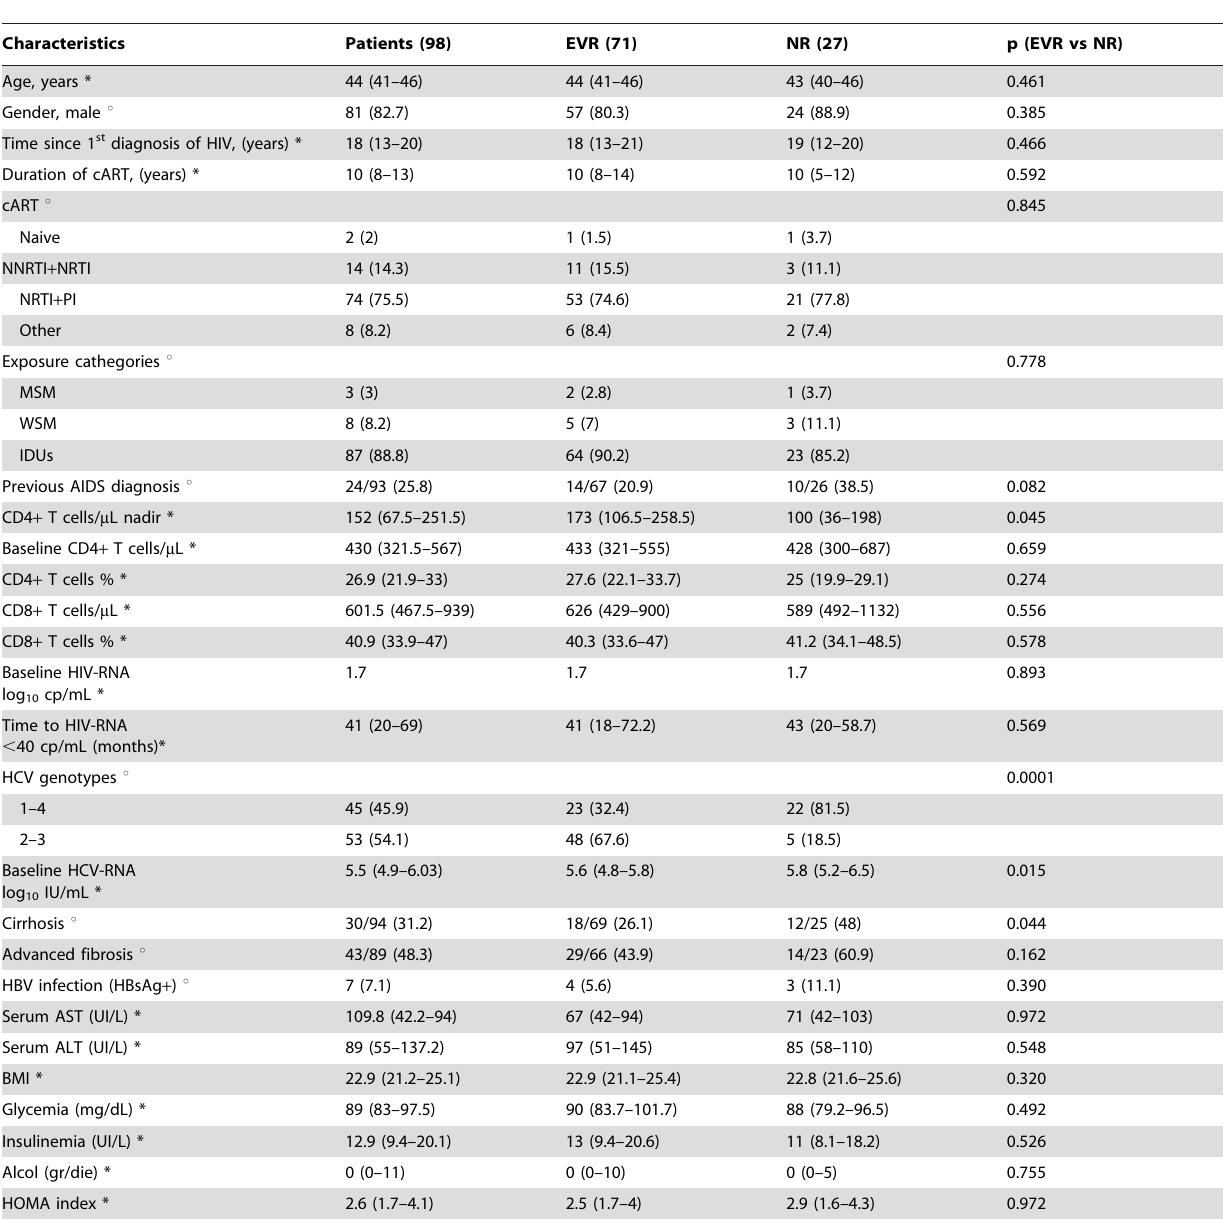
Table 1. Baseline demographic and immuno-virological characteristics of study